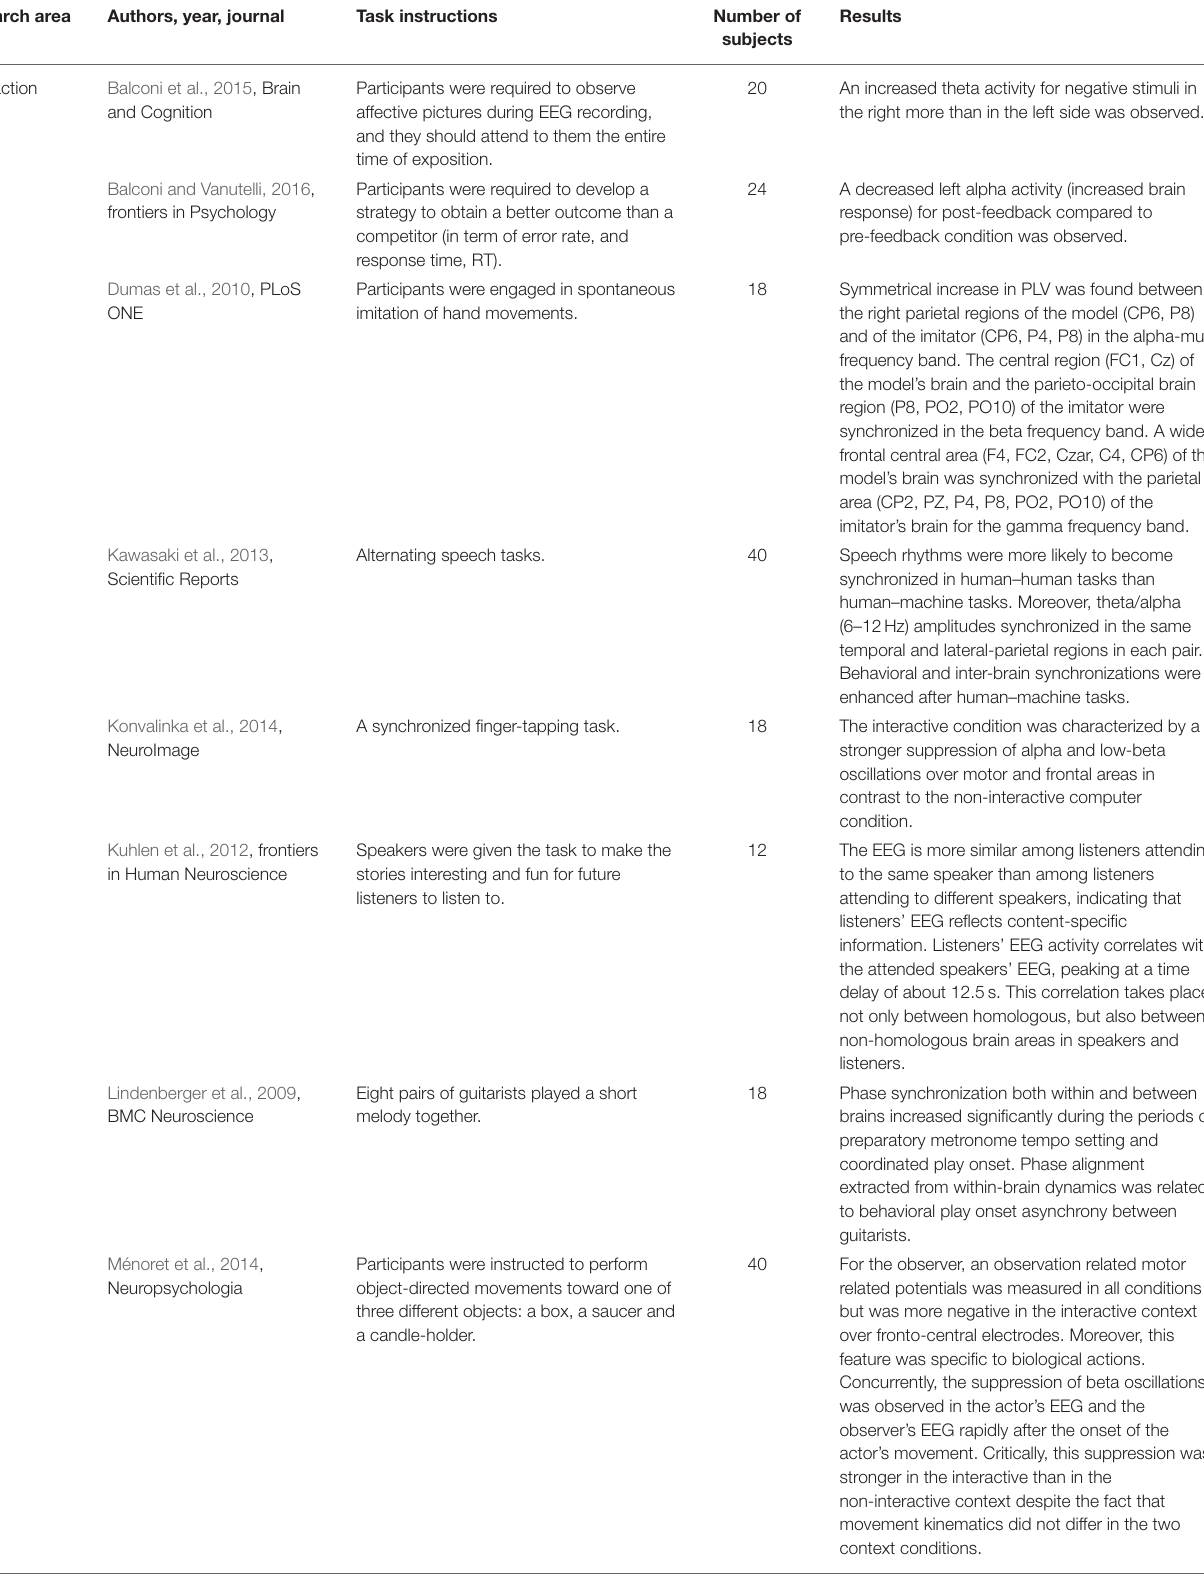
TABLE 1 | List of the studies mentioned with EEG-based hyperscanning